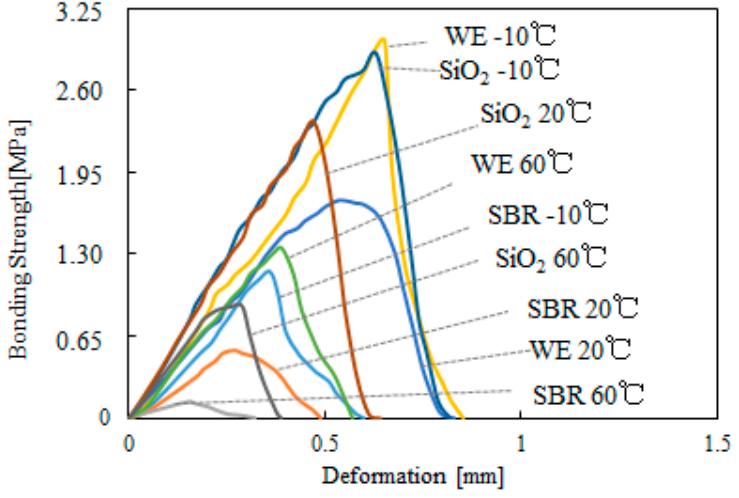
Figure 2. Typical strength–displacement curves of bonding strength tests.